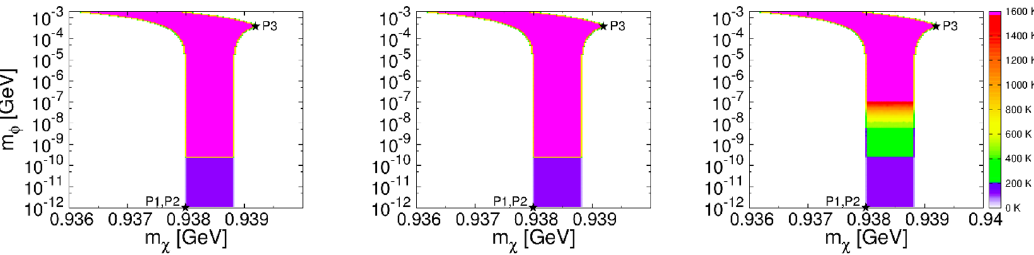
Figure 8 . The minimum value of T obs projected on the ( m (cid:31) ; m (cid:30) ) plane when (cid:31) is DM. The temperature scale is shown on the right panel. The stars mark the three benchmark points P1 , P2 , and P3 . Left-panel: attractive DM self-energy (cid:0) n Right-panel: repulsive DM self-energy + n